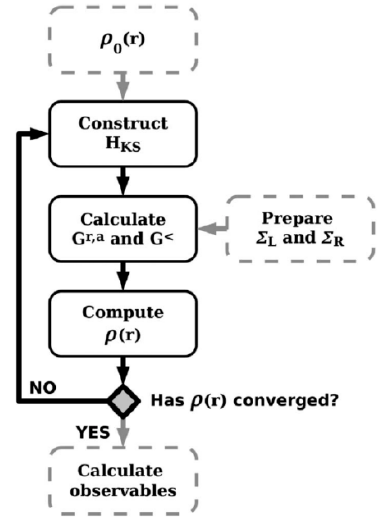
Figure 12. Illustration of the density functional theory (DFT)-nonequilibrium Green’s function (NEGF) self-consistent simulation flow [67].